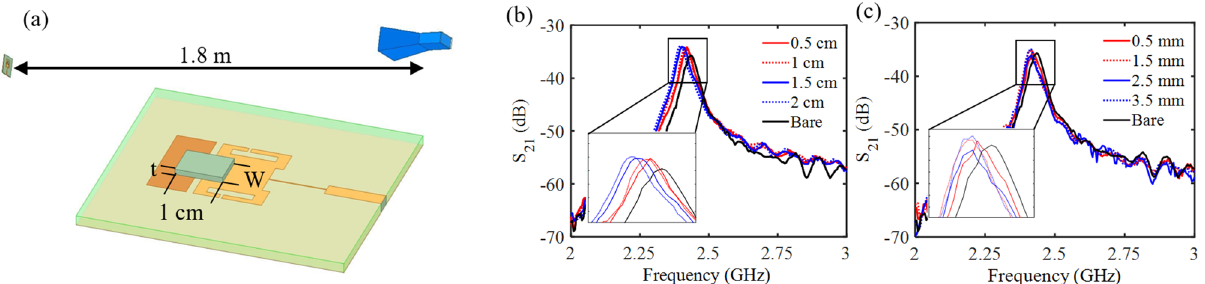
Figure 5. The ( a ) dual-antenna system simulated in HFSS with varying widths and thicknesses of ice on its most sensitive gap and the resonant profile of the transmission coefficient as ( b ) the width of ice varied from 0.5 to 2 cm and as ( c ) the ice thickness varied from 0.5 to 3.5